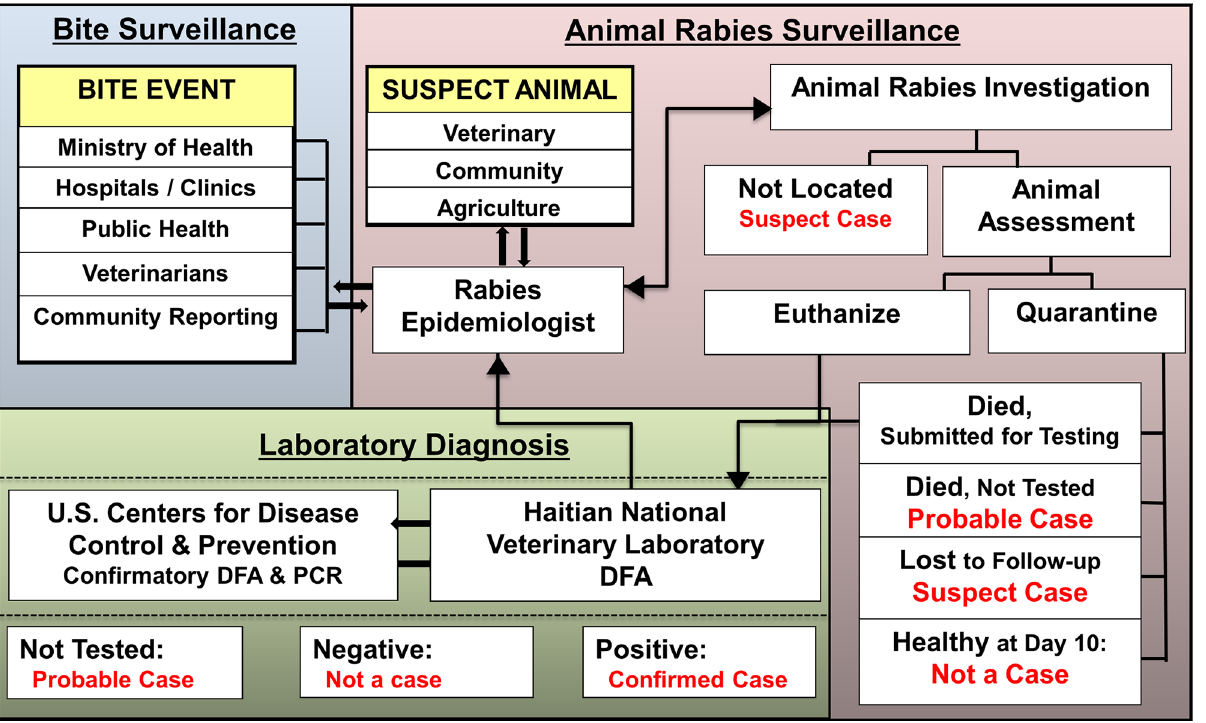
Fig 1. Haiti Animal Rabies Surveillance Program structure for reporting, investigation, and diagnostic testing of rabies suspect animals. * ARSO: Animal Rabies Surveillance Officer.